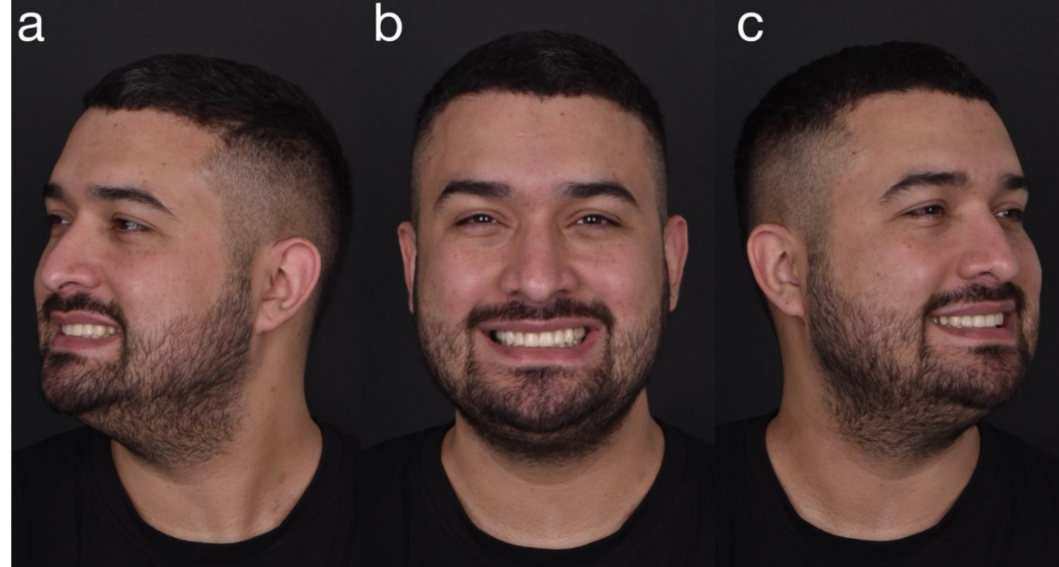
Figure 27. Final extraoral facial smiling pictures (( a ) left, ( b ) frontal, ( c ) right).